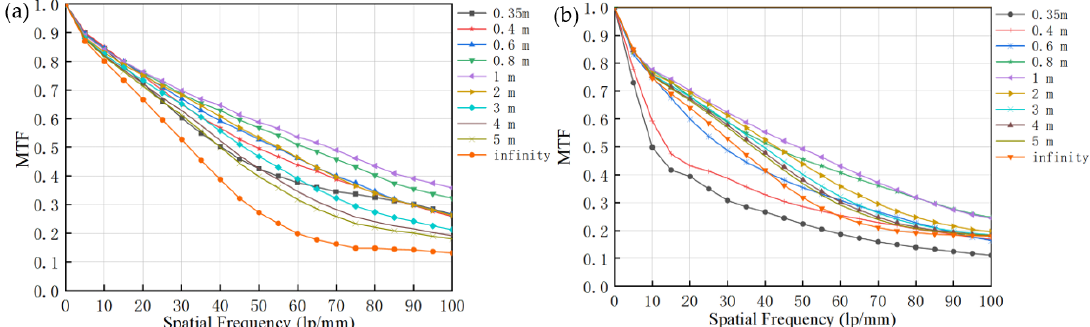
Figure 5. MTFs of the pseudophakic eye model at 0° field of view under polychromatic light for different object locations. ( a ) Under a pupil diameter of 3 mm. ( b ) Under a pupil diameter of 4.5 mm.